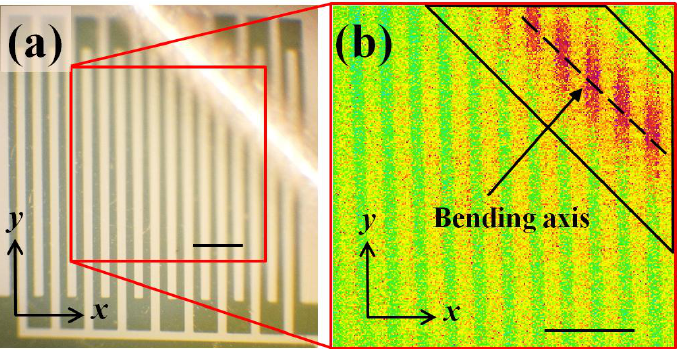
( b ) its temperature distribution map. The scale bars in ( a ) and ( b ) are both 300